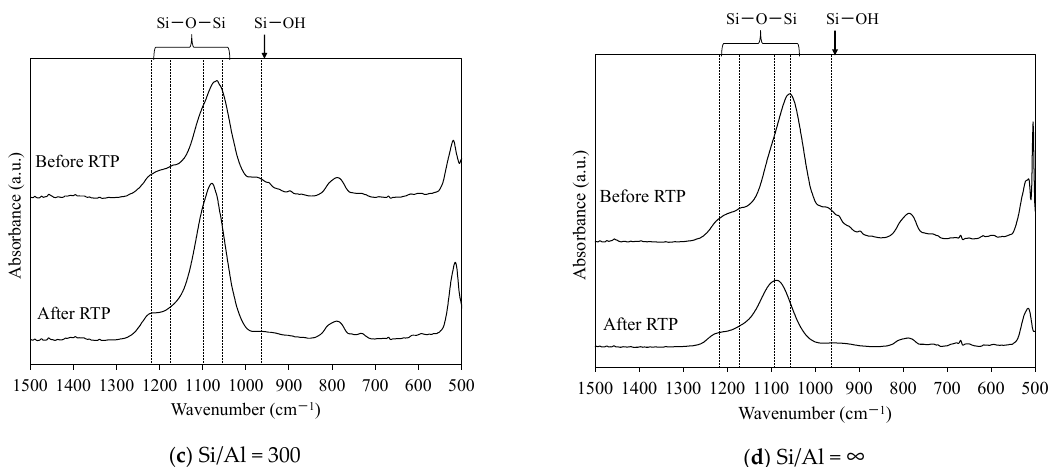
Figure 12. FTIR spectra (500 to 1500 cm − 1 ) of the as-made ZSM-58 zeolite crystals with different Si/Al molar ratios ( a – d ) before and after RTP treatment.